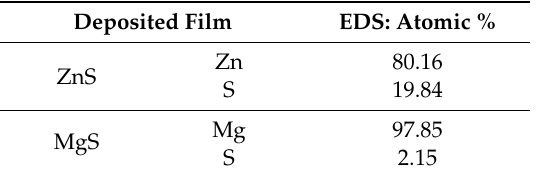
Table 1. Elemental compositions of ZnS and MgS thin film.